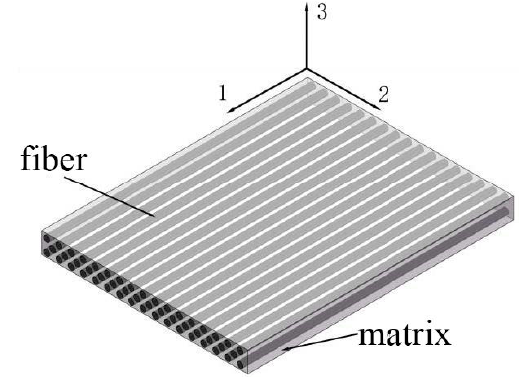
Figure 6. One-way fiberboard coordinate system.